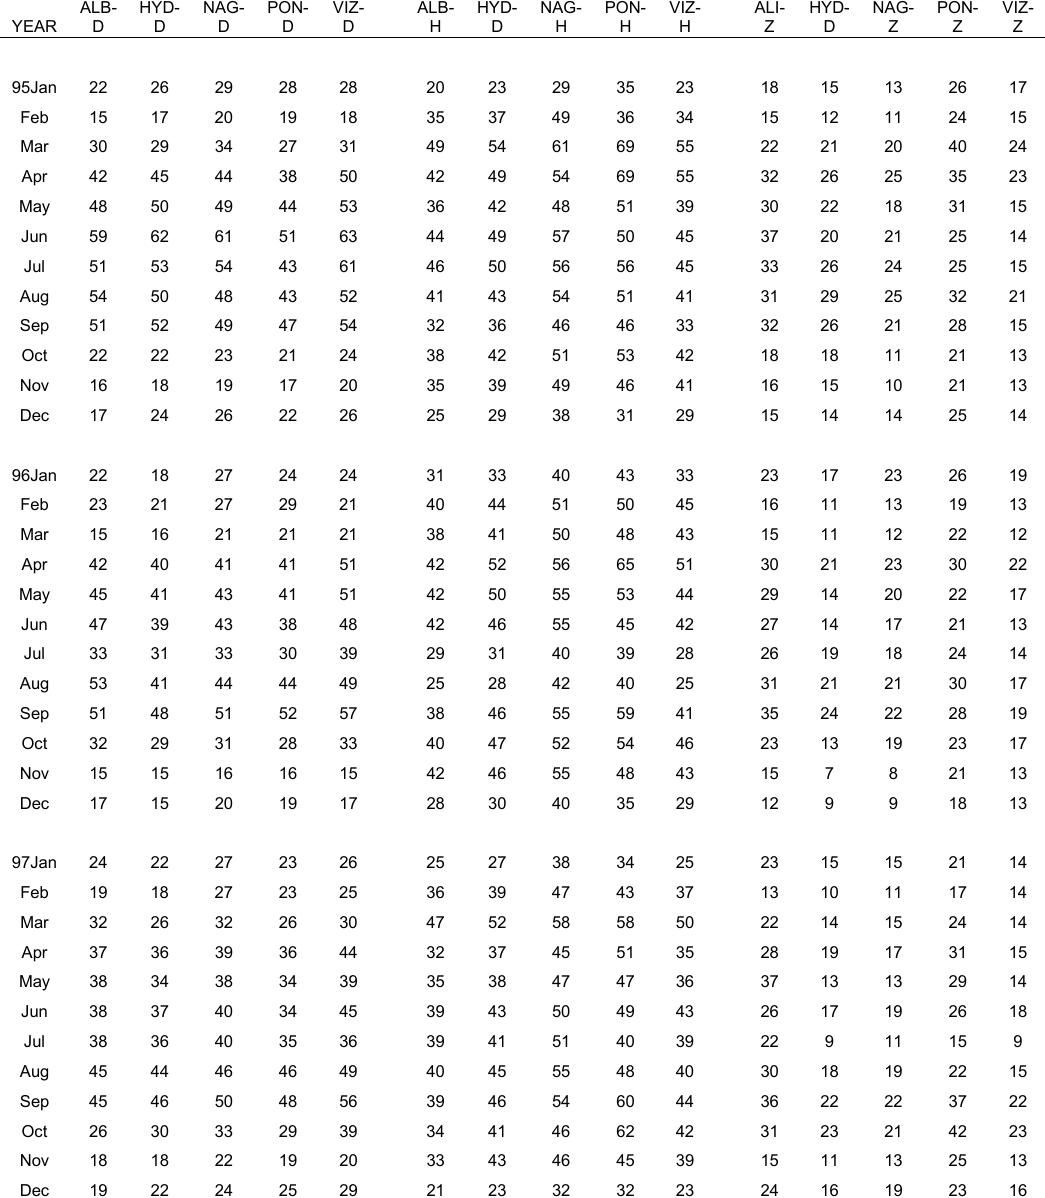
Table 2. Monthly variations for the components D, H and Z for the years 1995, 1996 and 1997 in nT. Monthly, variations for the components D, H and Z for the years 1995, 1996 and 1997 in